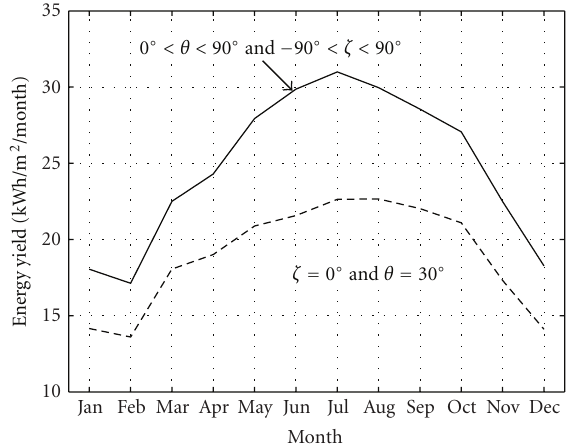
Figure 9: Energy yield of fixed (fixing both ζ and θ ) and two-axis (varying both θ and ζ ) PV systems for each month. The maximum energy yield occurs in also July for both lines. The gain of such tracking over the fixed one is 30.82%.